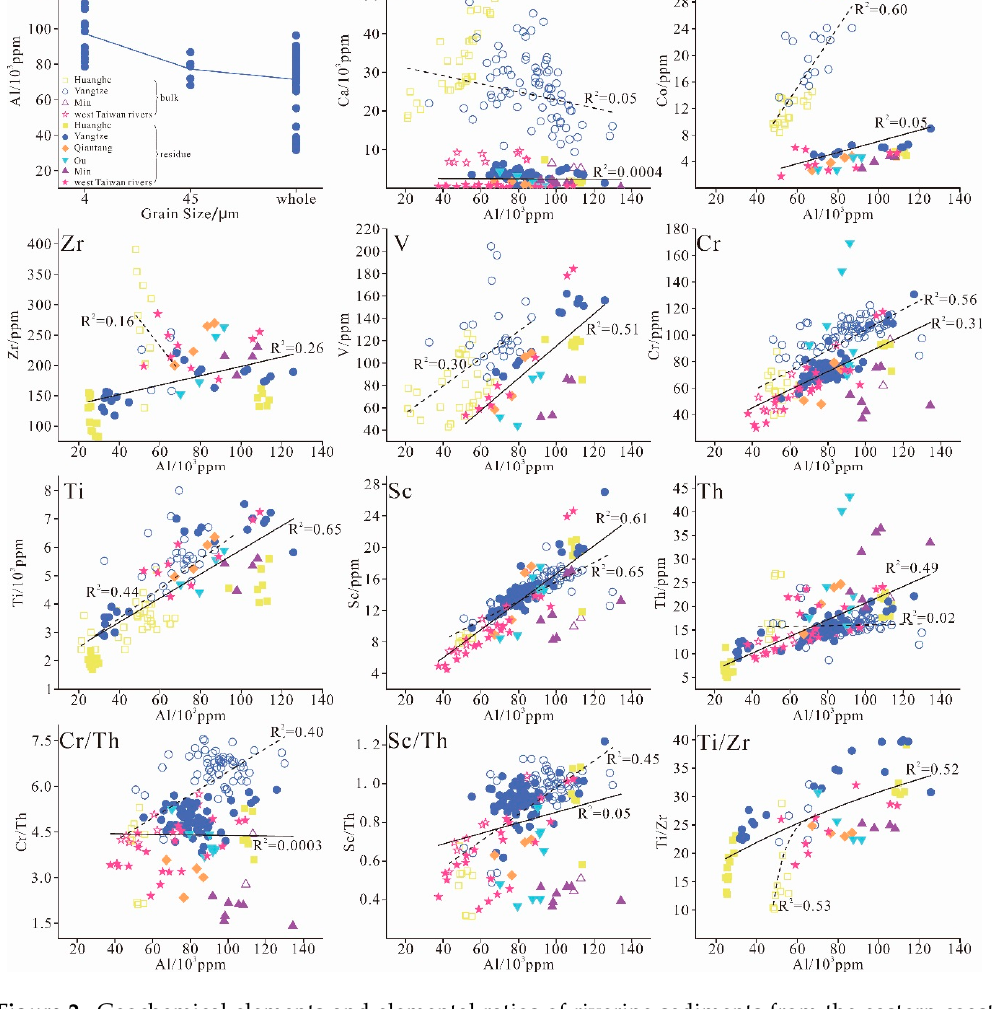
Figure 2. Geochemical elements and elemental ratios of riverine sediments from the eastern coast of China. The dotted line represents the element trend with Al of the bulk phase, and the solid line represents that of the residual phase.